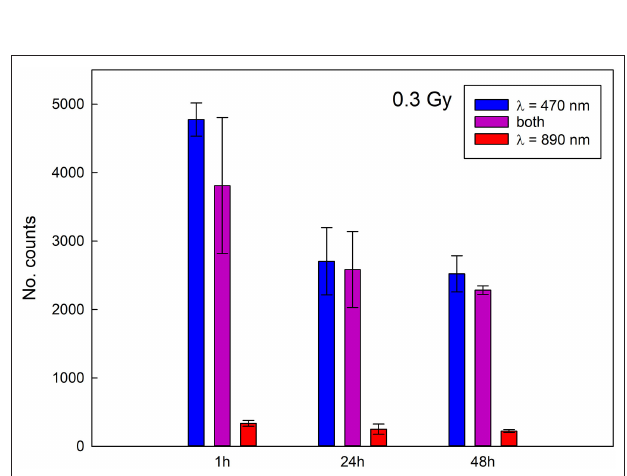
FIGURE 5 | Signal stability for samples irradiated to 0.3Gy (data acquired with Reader 1).